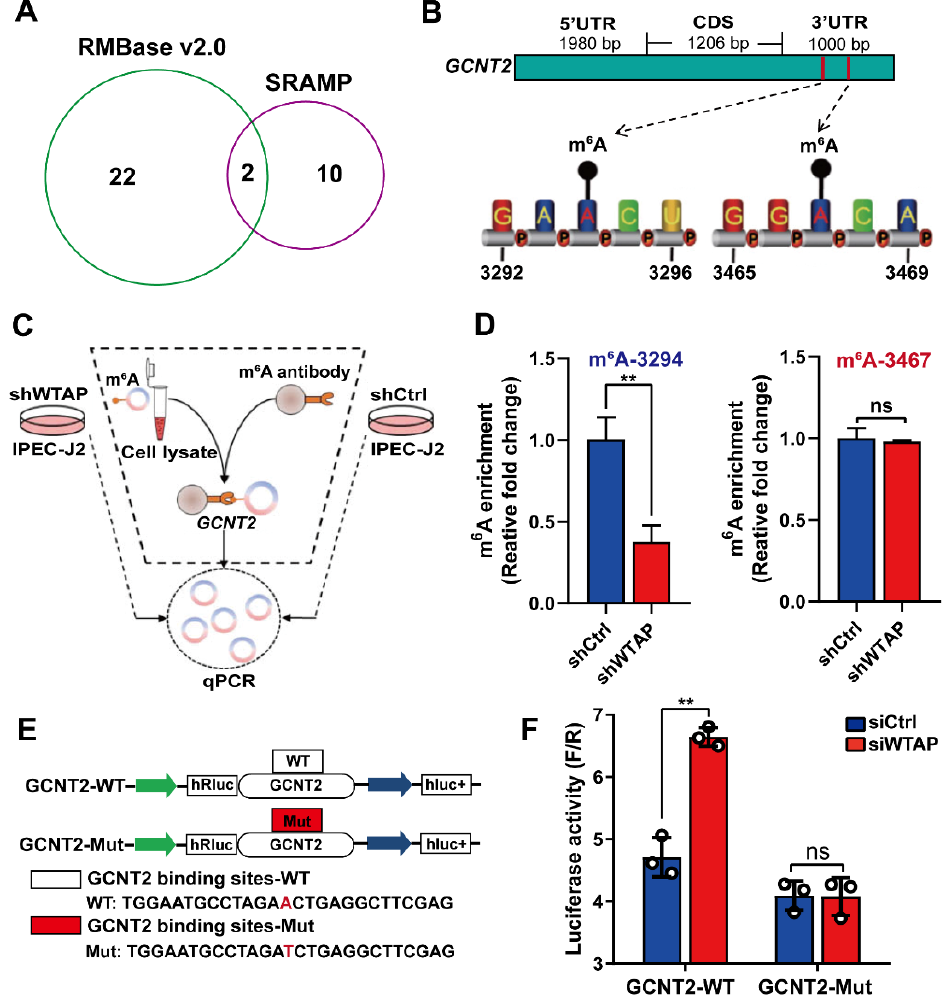
Figure 4. WTAP regulates GCNT2 expression via m 6 A methylation. ( A ) Predicted m 6 A sites in GCNT2 from overlapping results of SRAMP and RMBase v2.0 software. ( B ) Schematic diagram of predicted m 6 A sites in the 3′UTR of GCNT2 gene. ( C ) Flow diagram of m 6 A-specific immunoprecipitation (MeRIP) assays. ( D ) MeRIP assays for m 6 A-modified GCNT2 in shWTAP and shCtrl cell lines. ( E ) Construction of luciferase vector with GCNT2 wild- type 3′UTR (WT) or mutant - type 3′UTR (Mut). ( F ) Relative activity of the wild-type or mutant GCNT2 3′UTR firefly luciferase reporter in IPEC-J2 cells transfected with control or WTAP siRNAs. All data are presented as the mean ± SD, ** p < 0.01, ns p > 0.05.